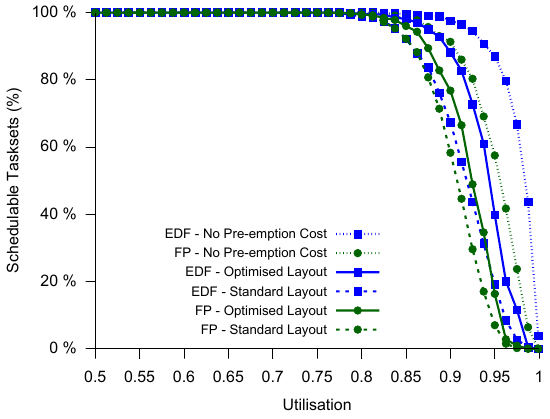
Figure 8 Percentage of schedulable tasksets at each utilisation level for the mixed case study with tasks randomly selected from both the PapaBench and Mälardalen and SCADE benchmarks (taskset cardinality